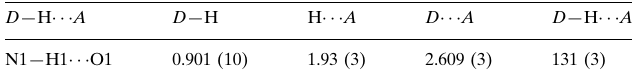
Hydrogen-bond geometry (A˚ , (cid:2)